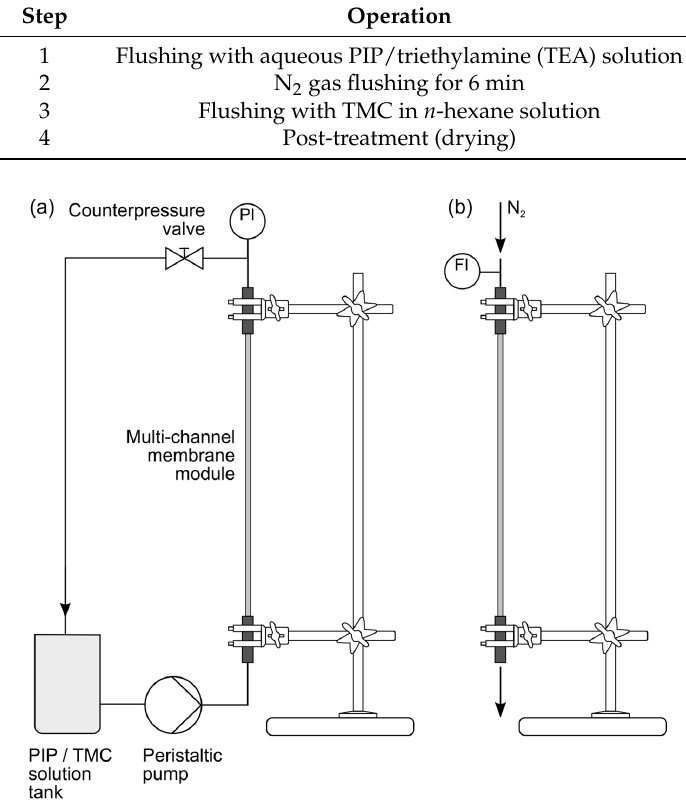
Figure 3. Preparation process of composite MCM; ( a ) processing of liquid PIP/TMC solutions; ( b ) flushing with nitrogen